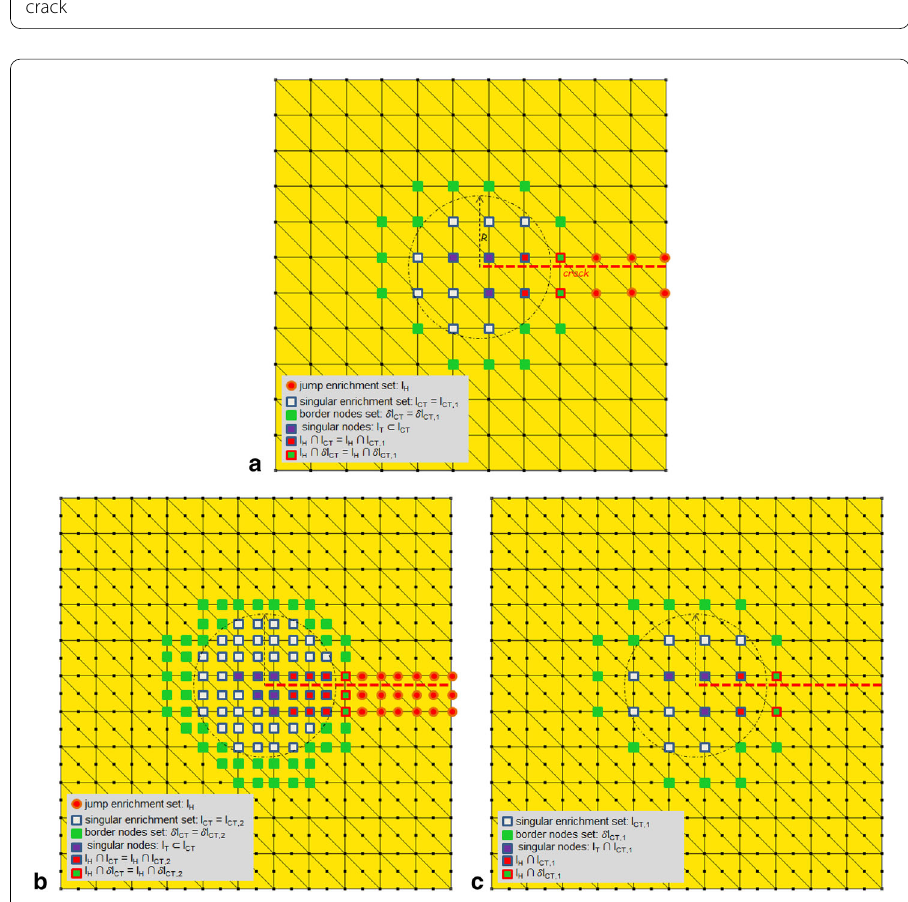
Fig. 5 Sets of enriched nodes around the crack. If the crack ends in the middle of the domain, additional enrichment functions are needed to model the singularity at the vicinity of the crack-tip. a illustration of the sets of nodes for a linear mesh (for which I CT = I CT, 1 ), b Illustration of the sets of nodes for a quadratic mesh (for which I CT = I CT, 2 ) and c Illustration of the sets I CT, 1 and δ I CT, 1 for a quadratic